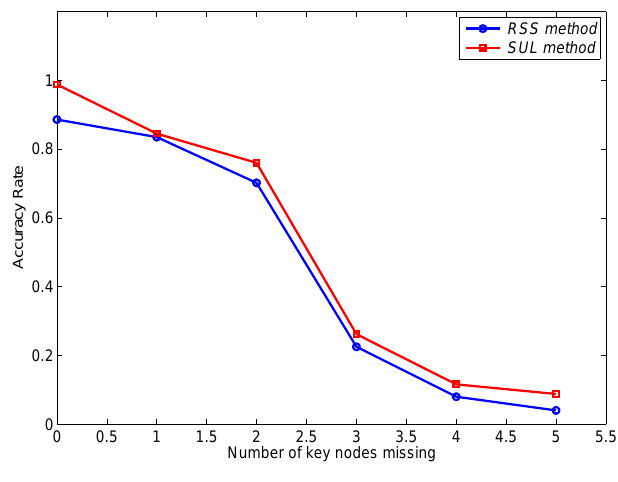
Figure 13. The impact of missing key nodes.